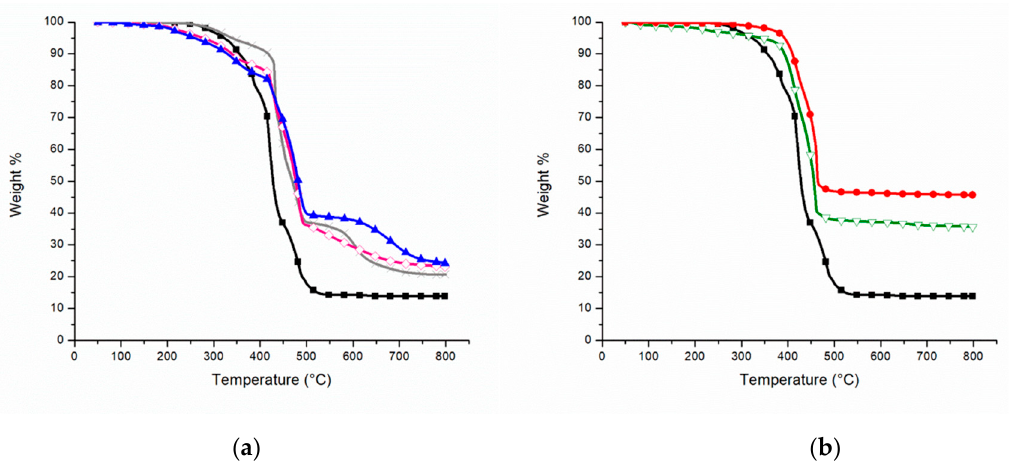
Figure 3. TGA in air of ( a ) PEAL (black square), PEALAPP 30 (grey cross), PEALIFR3031 (pink rhombus), PEALIFR4031 (blue triangle); ( b ) PEAL (black square), PEAL50MH (green triangle), PEAL60MH (red circle).